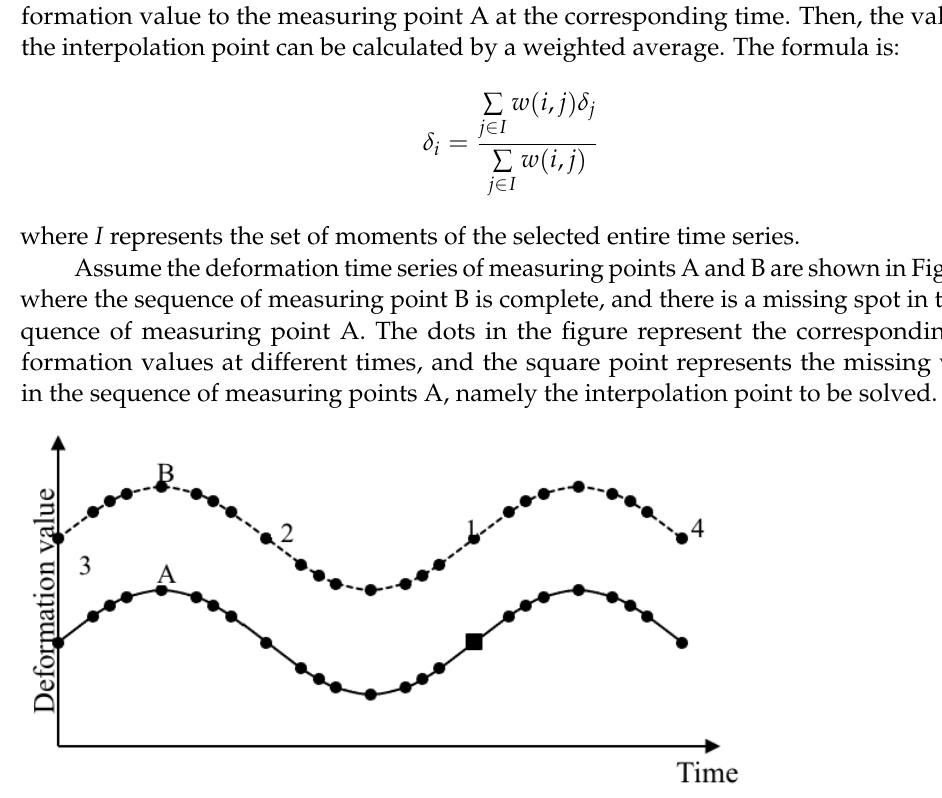
Figure 1. Schematic diagram of single value missing.